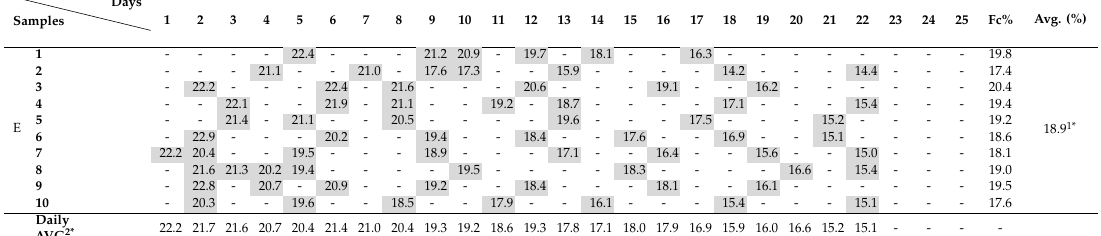
Table 15. Filler content measurement result (specimen